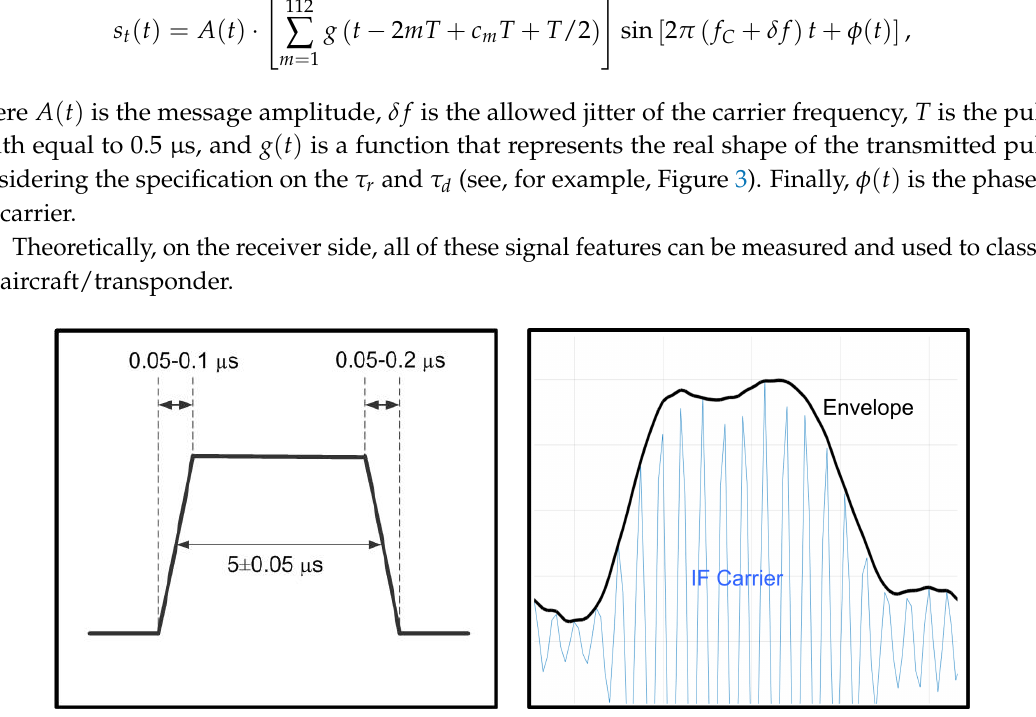
Figure 3. ADS-B pulse shape (on the left) and (on the right) a real example of ADS-B pulse (the two lines represent the IF signal and the relative